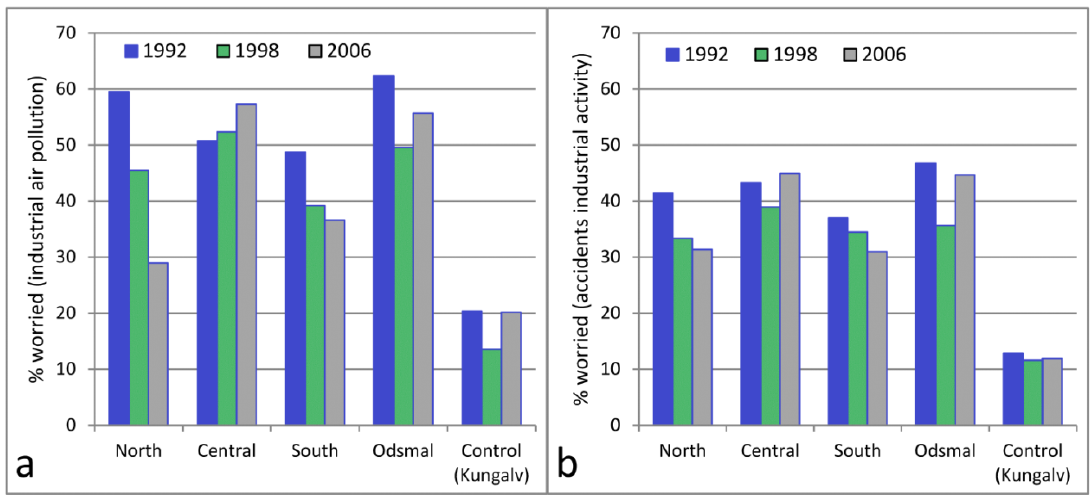
Figure 6. Prevalence of worry about industrial activity for each exposed area (North, Central, and South Stenungsund, and Odsmal) and the control area (Kungalv). Worry about health effects of industrial air pollution ( a ); worry about accidents caused by industrial activity ( b )